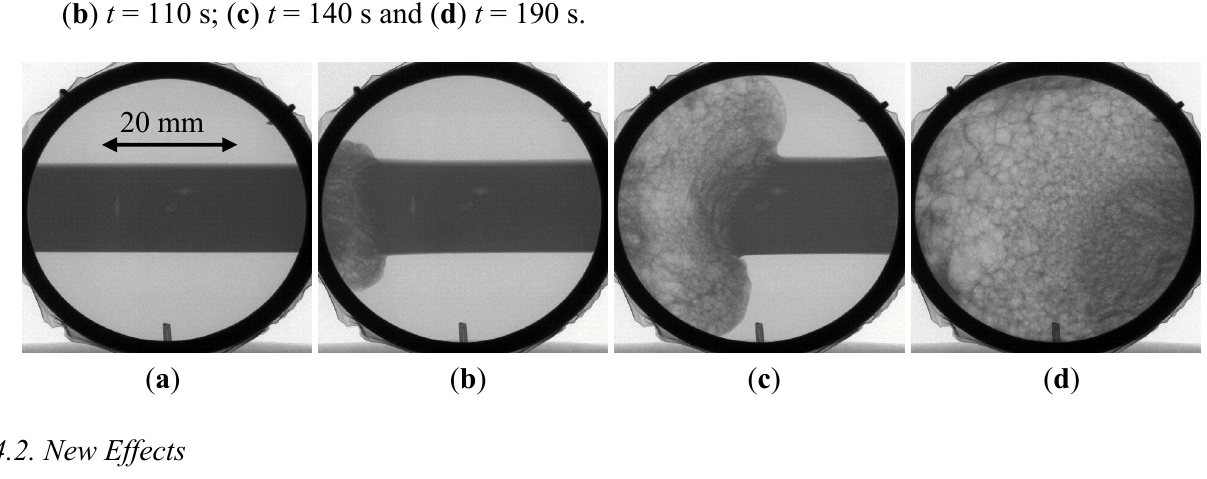
Figure 3. X-ray radioscopic observation of the filling of a cylindrical steel mold by AlSi9 foam in an inhomogeneously heated precursor ( T = 700 °C, Δ T ≈ 2.5 K/mm) at ( a ) t = 1 s;